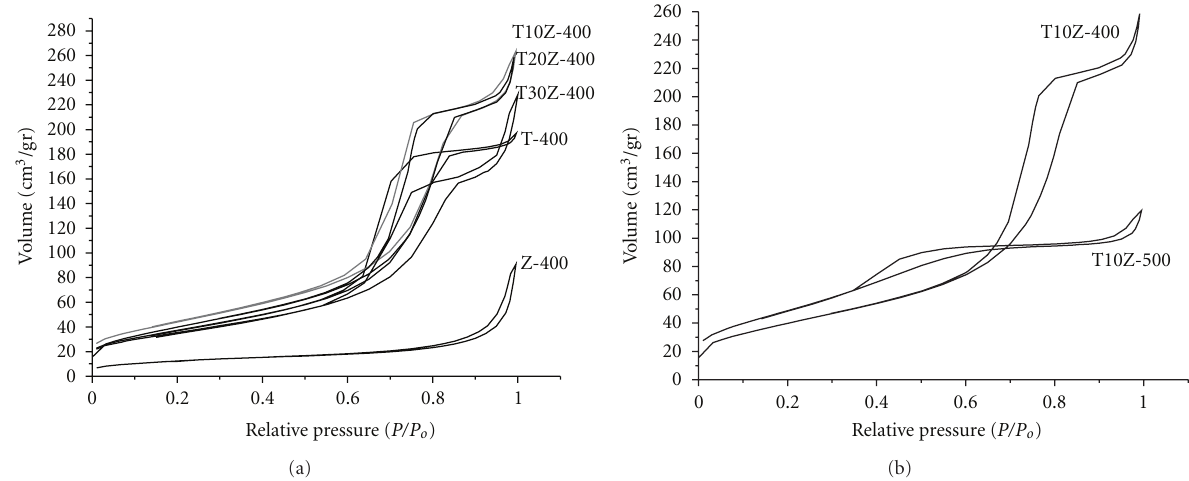
Figure 8: Adsorption-desorption N 2 isotherms of the (a) T10Z-400, T20Z-400, T30Z-400, T-400, and Z-400 samples and (b) T10Z-400 and